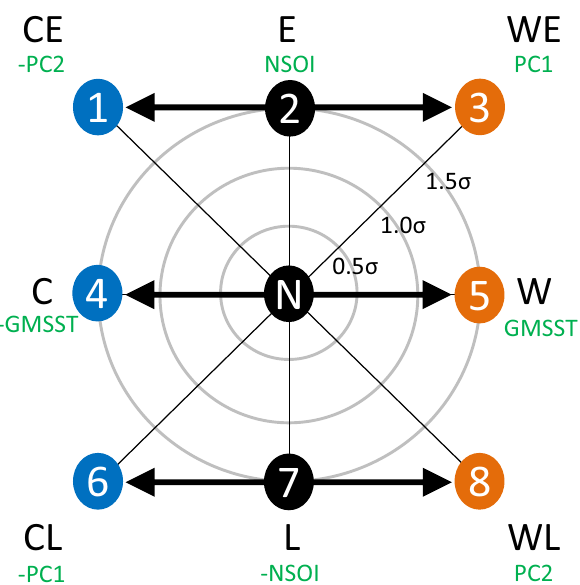
Figure 1. Eight modes of environmental variability. A continuous variability space is formed by the ENSO status (NSOI) and global ocean warmth (GMSST). PC1 and PC2 are the two principal components, which respectively represent the in-phase and out-of-phase modes of GMSST and NSOI. The eight modes of environmental variability are denoted as “Colder El Niño mode (CE)”, “El Niño mode (E)”, “Warmer El Niño mode (WE)”, “Colder mode (C)”, “Warmer mode (W)”, “Colder La Niña mode (CL)”, “La Niña mode (L)”, and “Warmer La Niña mode (WL)” around the “Normal (N)” as respectively numbered from 1 to 8. Three circles indicate 0.5 σ , 1.0 σ , and 1.5 σ outwards. CE and WE demonstrate the cold and warm anomalies around E,